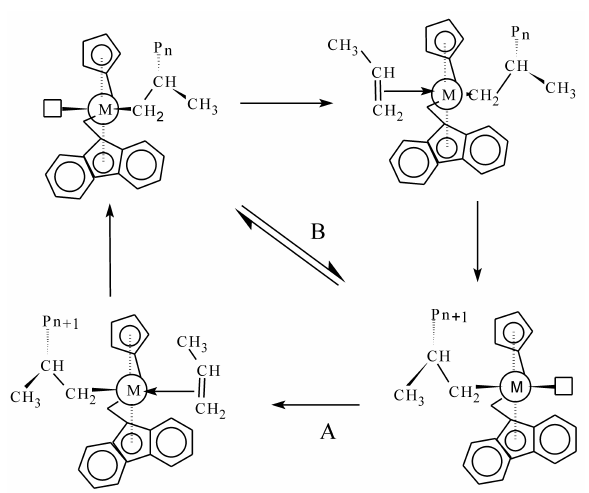
Figure 2. Polymerization